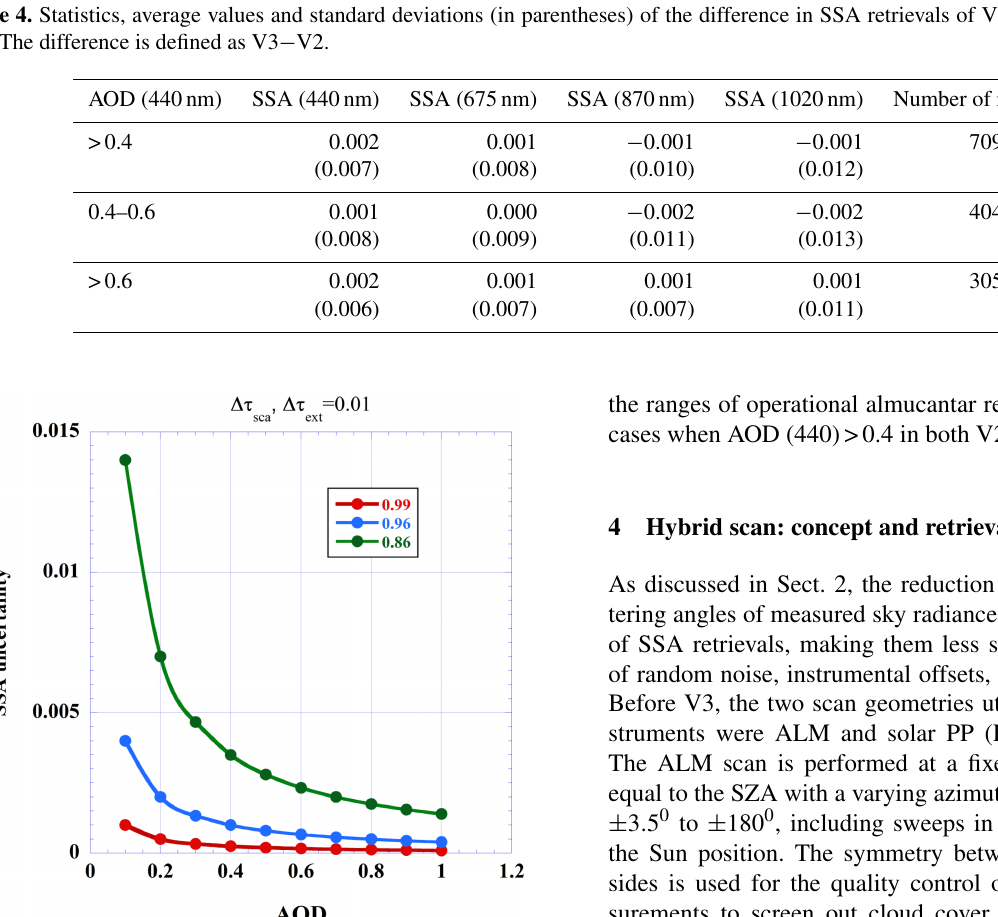
for GSFC, 0.9 % (0.5 %) and 3.8 % (1.7 %) for Mongu,